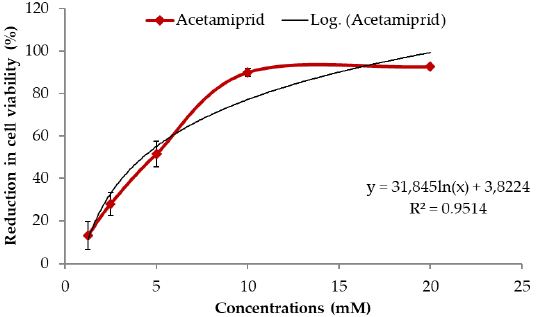
Figure 1. Effects of ACE (0–20 mM) on cell viability by MTT assay (A) in SH-SY5Y cells after 24 h of treatment. IC50 value of ACE was calculated as 4.26 mM according to the formula of logarithmic curve (black line). Data are presented as mean ± SD.